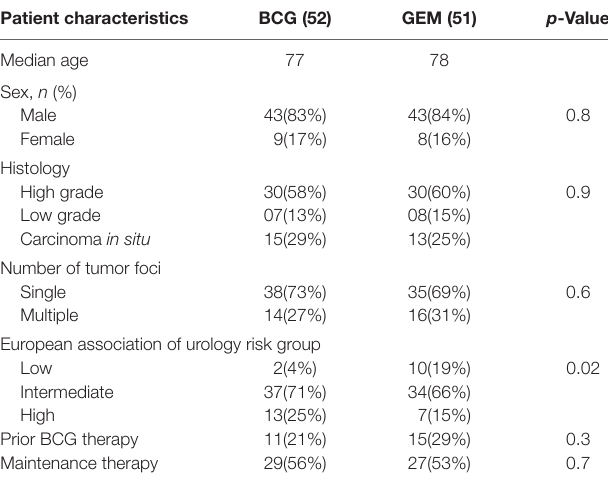
TaBle 1 | Patient characteristics.